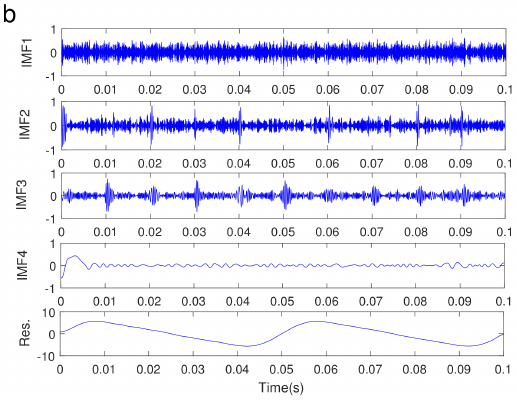
Figure 6. The decomposed BLIMFs of the simulated vibration signal using VMD ( a ) and IMF3 using EMD ( b ).